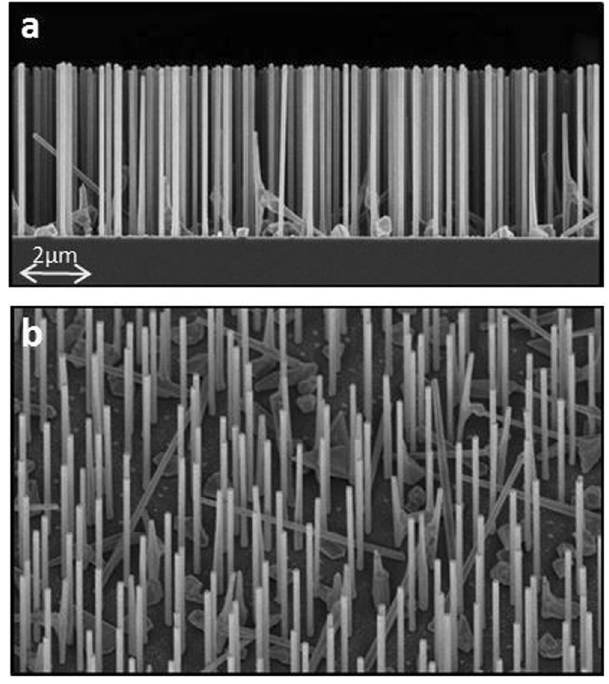
Figure 2. ( a ) SEM edge view of Sample A with NWs of L = (4750 ± 34)nm, D = (138 ± 5)nm. ( b ) Tilted (30°) SEM image of 3D distribution of Sample